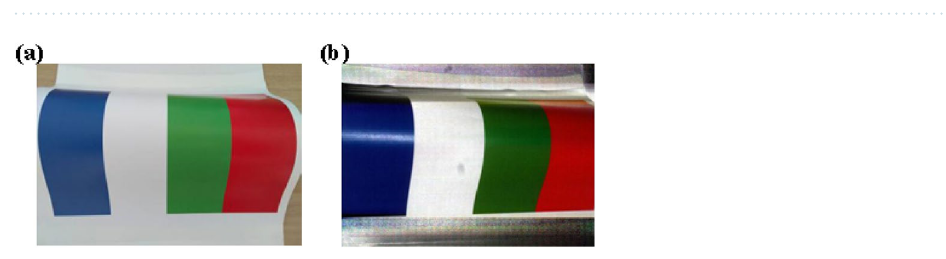
Figure 4. Characteristic of the camera at different exposure time. ( a ) Red light projection. ( b ) Green light projection. ( c ) Blue light projection. ( d ) White light projection.